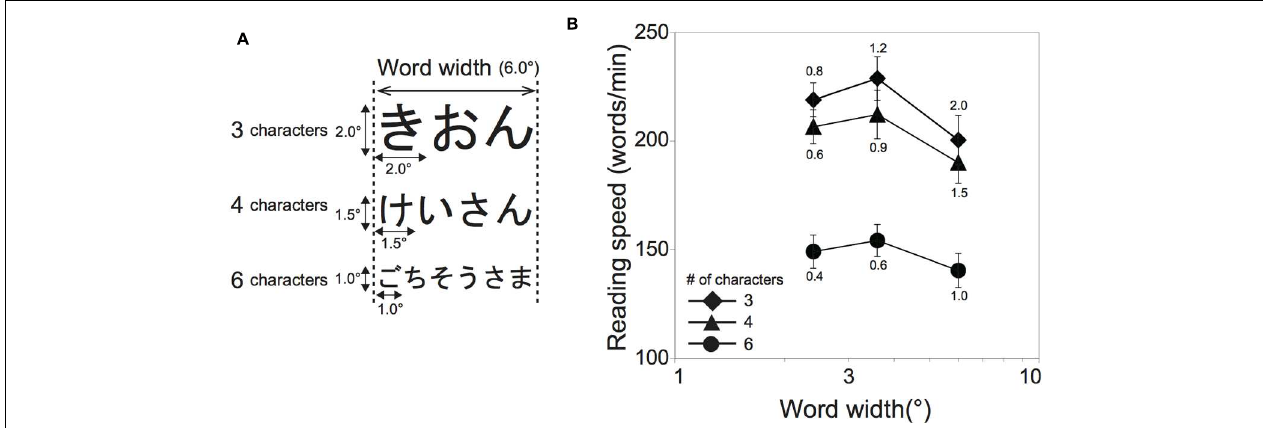
FIGURE 4 | Schematic illustrations of experimental stimuli and results of Experiment 2. (A) The stimuli for the 6 ◦ word width condition are shown. (B) Reading speed (ms/word) is shown as a function of word width ( ◦ ) in Experiment 2 ( N = 15). Word length (number of characters) is designated by symbol type. The number added above or below each symbol is the character size for the condition. Error bars denote the standard error of the mean.